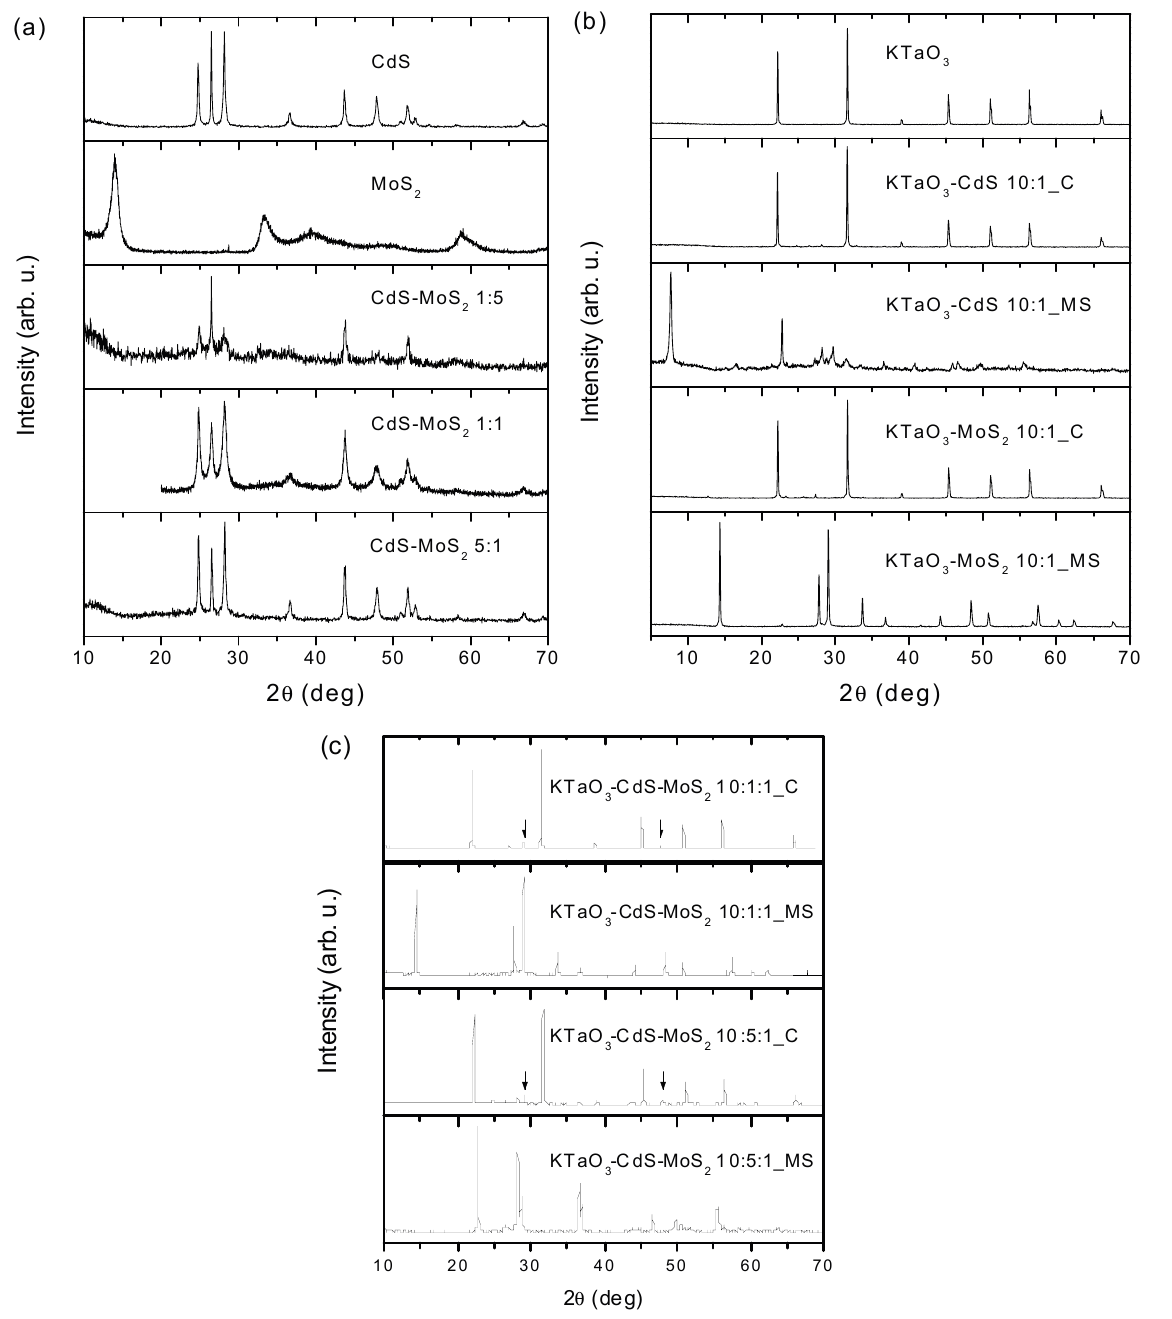
Figure 1. Powder XRD patterns for ( a ) single CdS, MoS 2 and binary CdS-MoS 2 nanocomposites, ( b ) single KTaO 3 and binary KTaO 3 -based nanocomposites, ( c ) ternary KTaO 3 -based